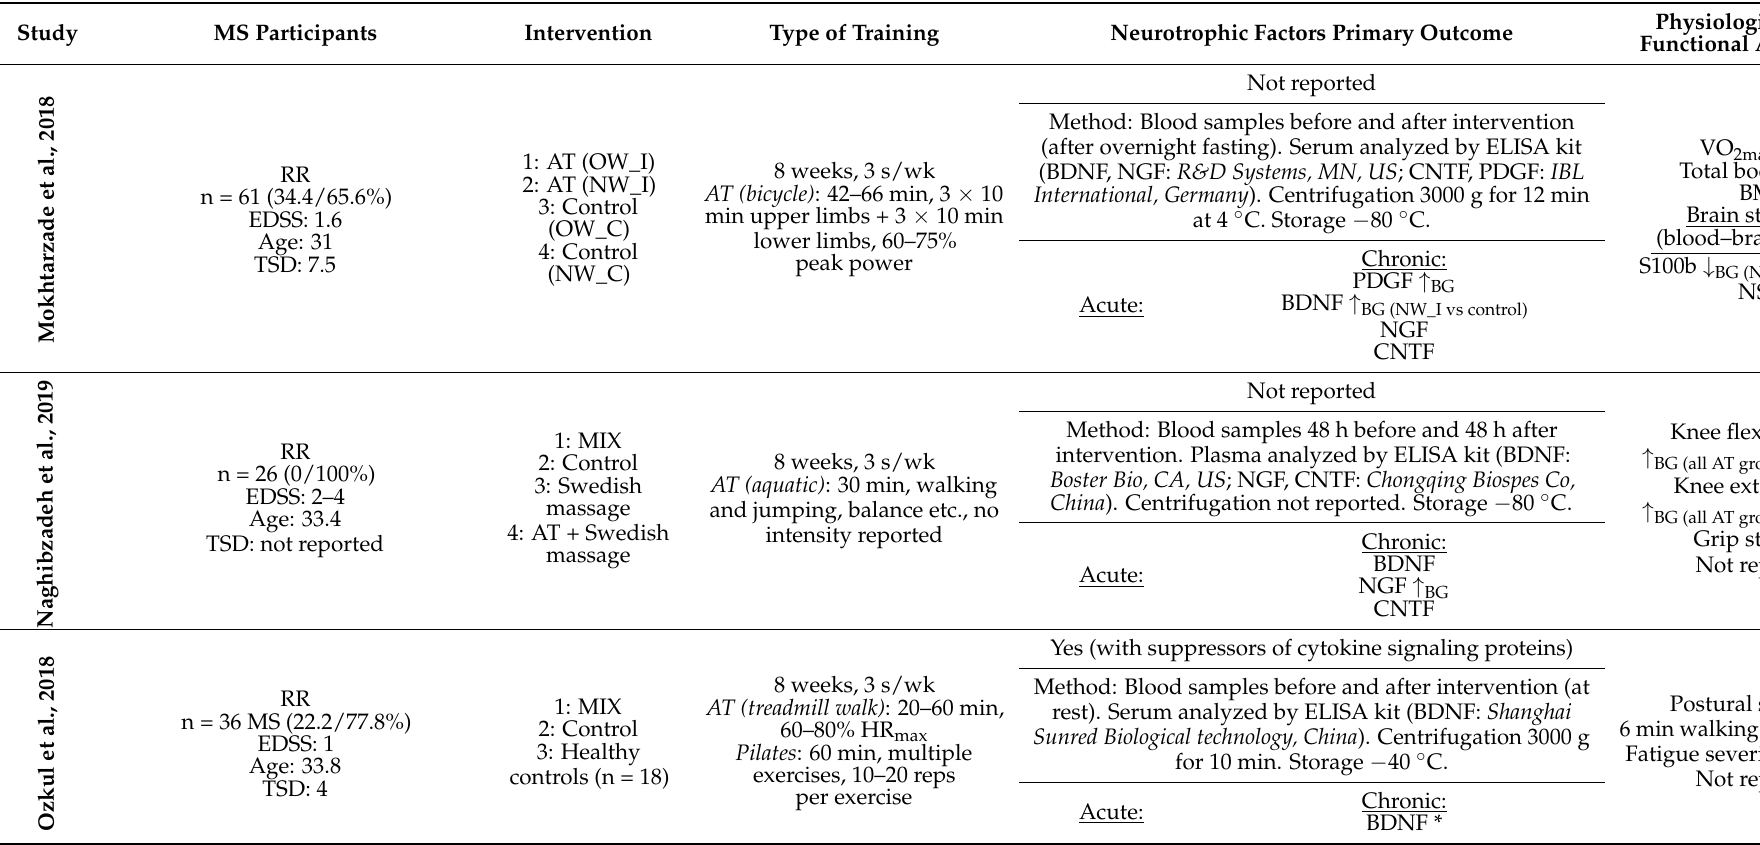
Type of Training Neurotrophic Factors Primary Outcome